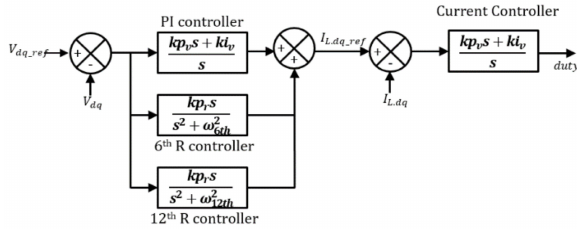
Figure 15. Block diagram of the PI + MR controller-compensated nonlinear load.